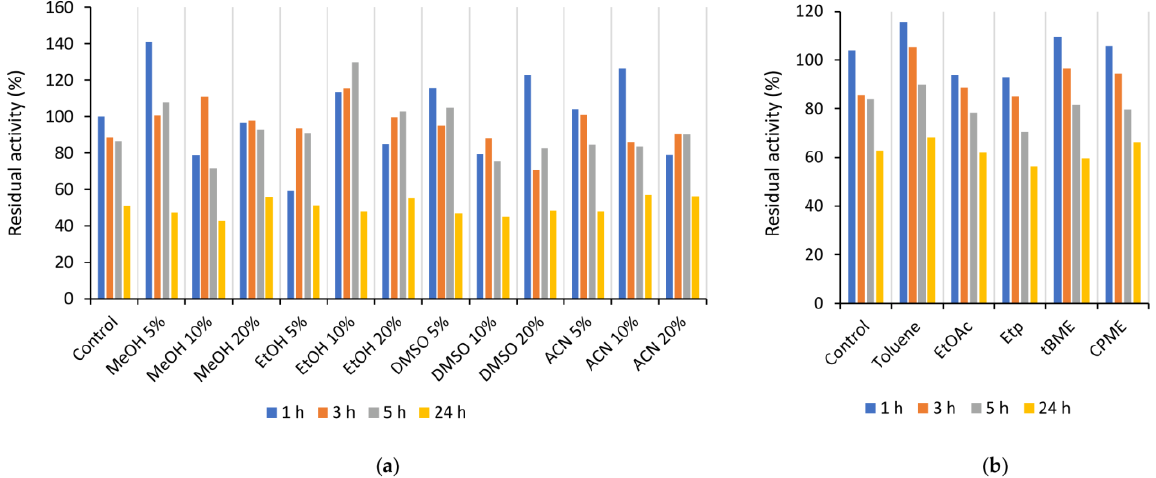
Figure 5. Stability of Is2-SDR in the presence of different organic solvents. ( a ) water-miscible organic solvents; ( b ) biphasic systems with water-immiscible organic solvents. ethyl acetate (EtOAc), petroleum ether (Etp), tert -butyl methylether (tBME), and